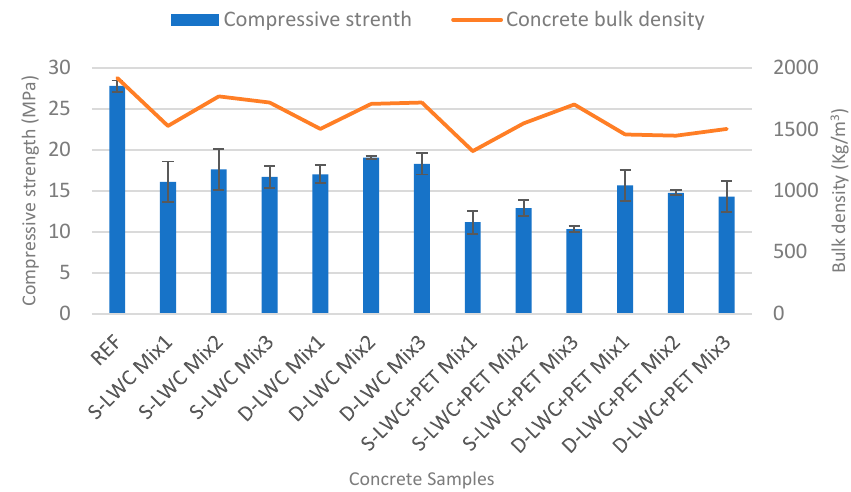
Figure 5. Effect of concrete density on the compressive strength.